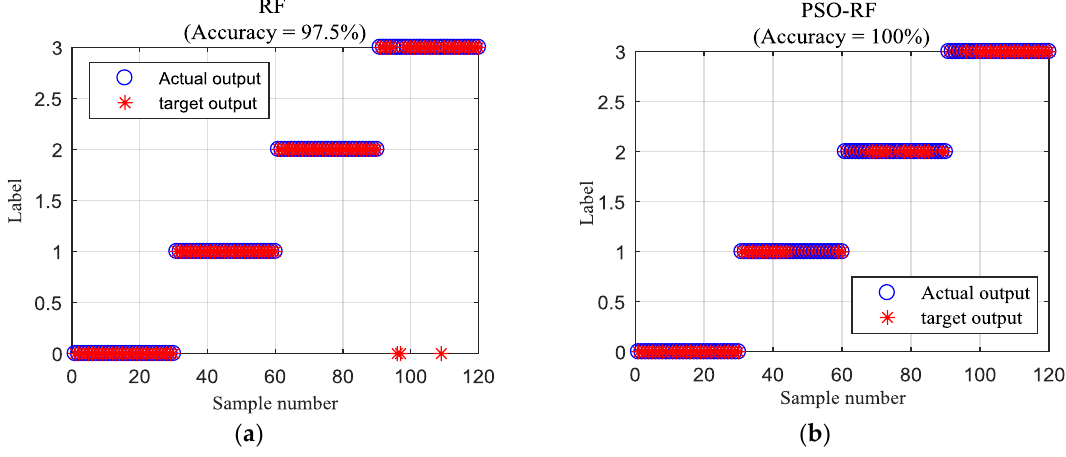
Figure 17. Classification results of: ( a ) RF; ( b ) PSO-RF.